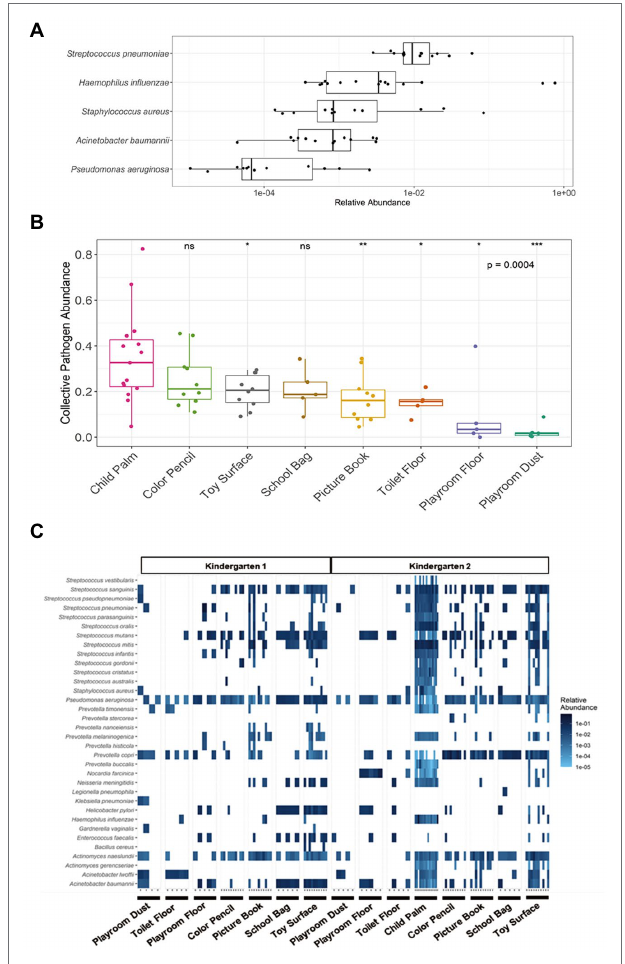
FIGURE 3 | Presence of potential microbial hazards in various surfaces of kindergartens. (A) Distribution of potentially antibiotic-resistant bacteria on Child Palm ( n = 15) with mean relative abundance of >0.001%. (B) Significant difference in collective relative abundance of identified microbes with potential human health concerns was observed across the seven sampled locations and child palm in Kindergarten 2( p = 4.18 × 10 −4 , Kruskal–Wallis). With Child Palm as the reference group, Toy Surface ( p = 0.0357), Picture Book ( p = 0.0080), Toilet Floor ( p = 0.0107), Playroom Floor ( p = 0.0146) and Playroom Dust ( p = 2.58 × 10 −4 ) showed significantly lower relative abundance of pathogens. The p values above the boxplots were derived via the Mann– Whitney U-test: n.s., not significant, * p ≤ 0.05, ** p ≤ 0.01, *** p ≤ 0.001. (C) Heatmap of the identified microbes of potential human health concern across the seven different sampled sites of both kindergartens and the child palms. Only those species with mean relative abundance of >0.001% across the individual sites were